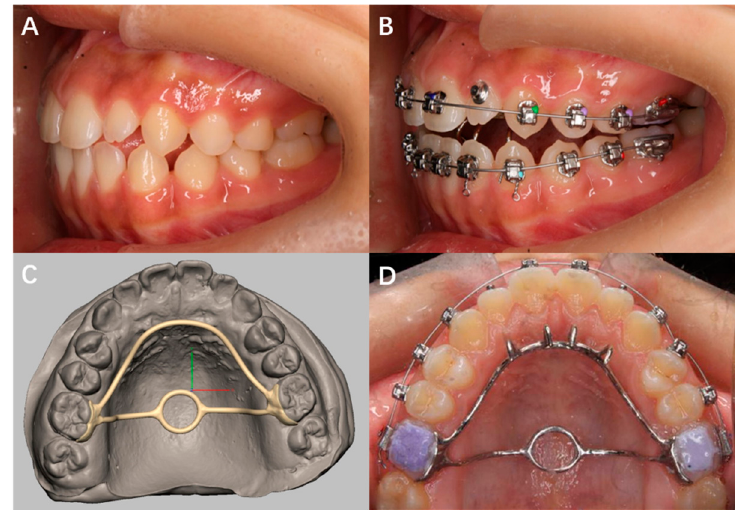
Figure 7. ( A ) A habit of tongue thrusting seen from an intraoral photograph; ( B ) the disappearance of tongue thrusting after wearing the 3D TPA; ( C ) digital design of a special 3D TPA ( D ) 3D TPA with palatal thorns bonded on teeth.